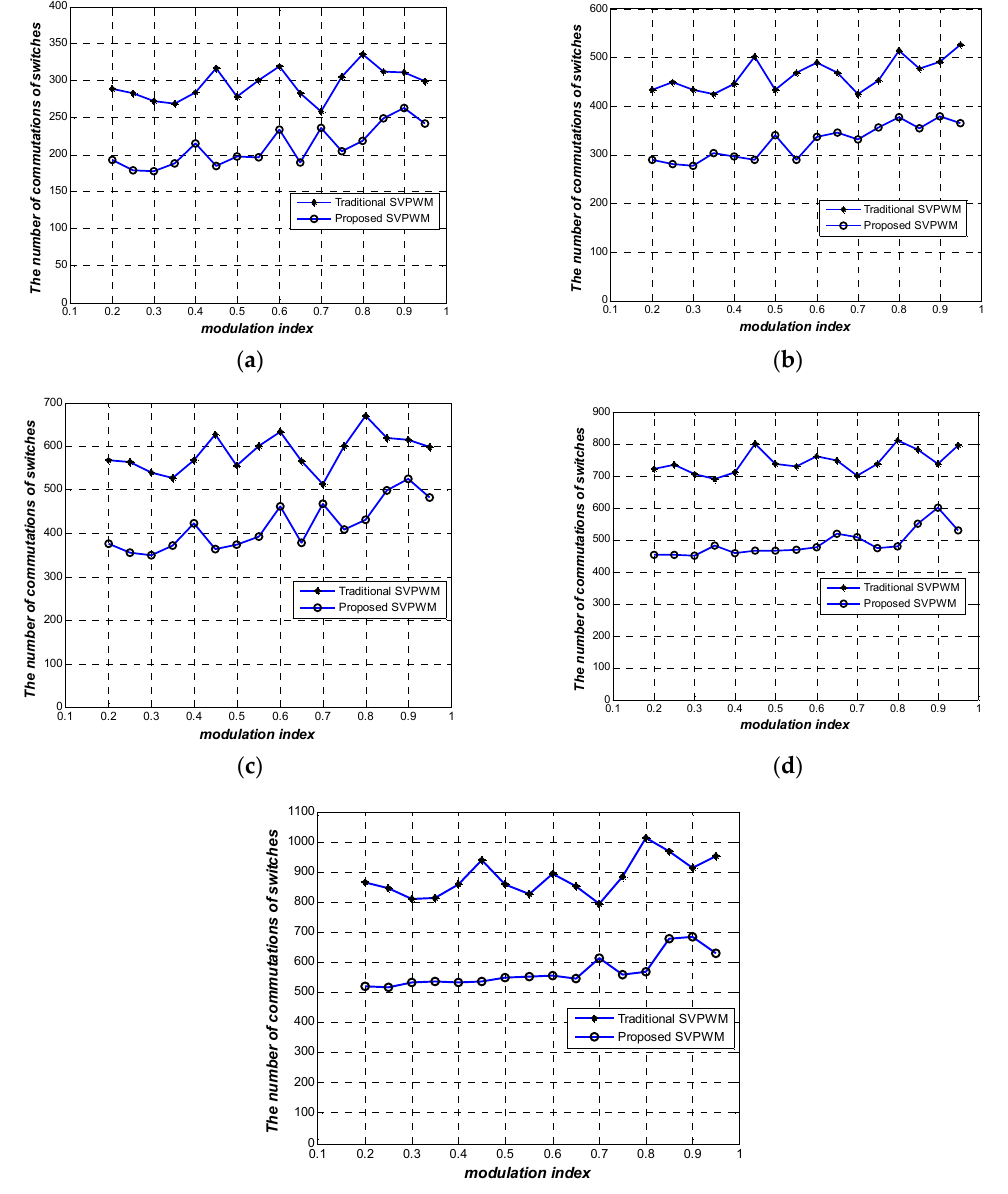
Figure 22. Numbers of commutations of switches with different number of sampling points in one period, ( a ) 42 sampling points; ( b ) 64 sampling points; ( c ) 84 sampling points; ( d ) 105 sampling points; ( e ) 126 sampling points.